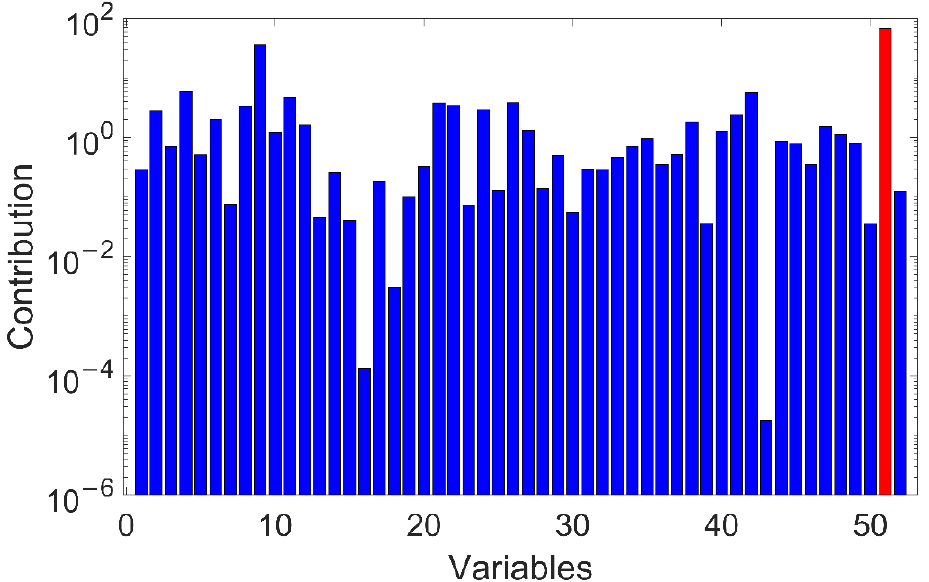
Figure 11. Contribution plots of fault 11.